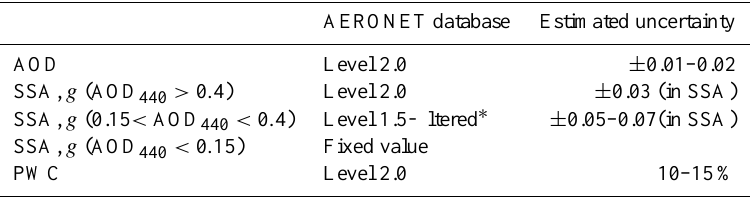
Table 2. Summary of AERONET data used for ARE calculations: aerosol optical depth (AOD), single scattering albedo (SSA), asymme- try factor ( g ), precipitable water vapor column (PWC). Estimated absolute uncertainty of AOD and SSA is given according to Dubovik et al. (2002) and PWC error according to Holben et al. (1998).